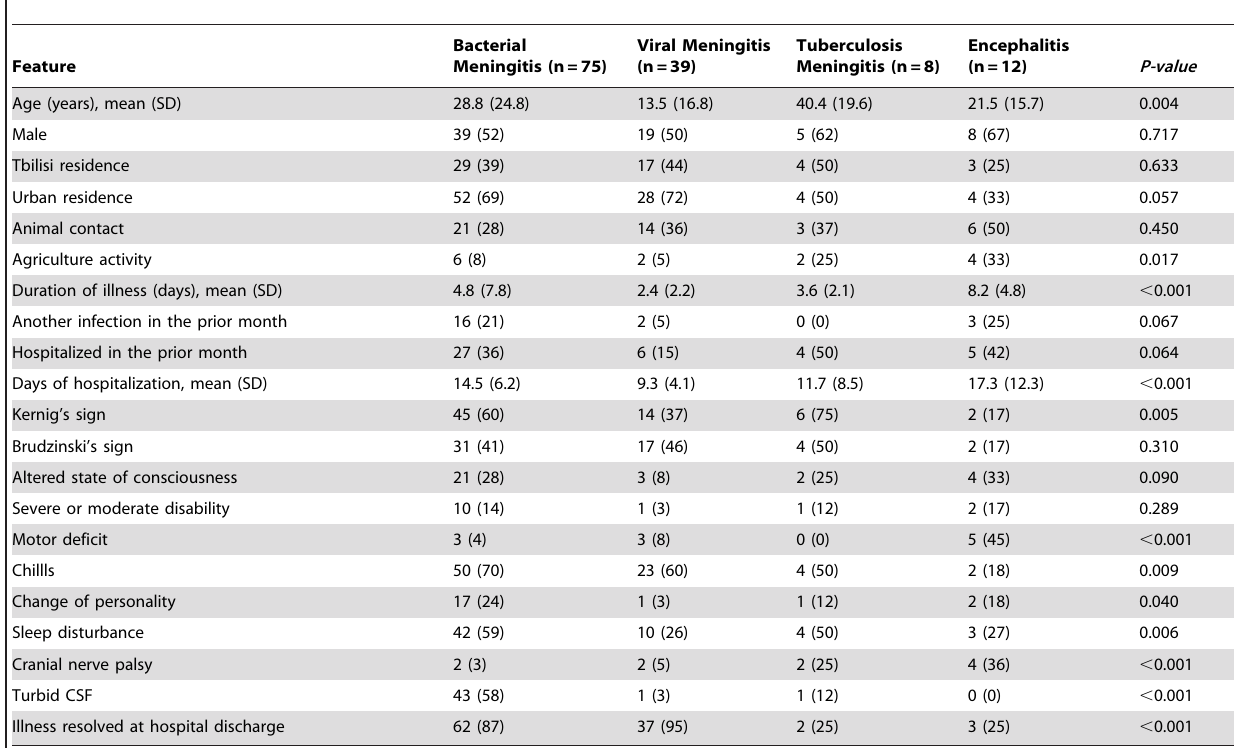
Table 4. Selected characteristics of the study patients with acute central nervous system infections classified by clinical diagnosis, country of